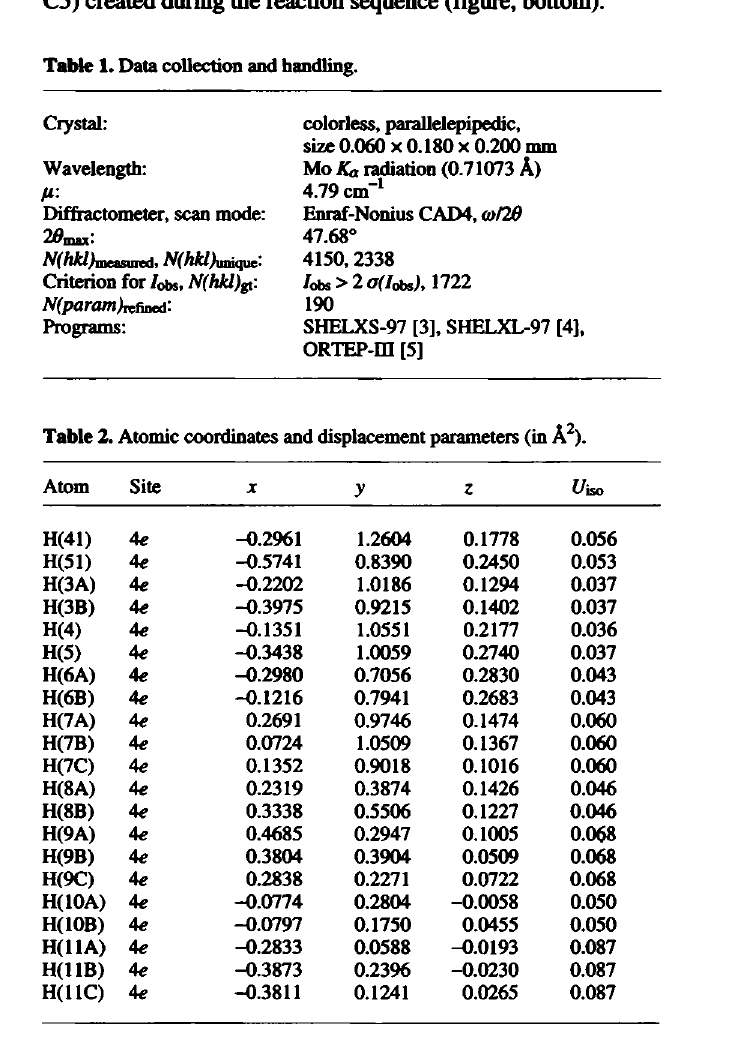
Table 1. Data collection and handling.